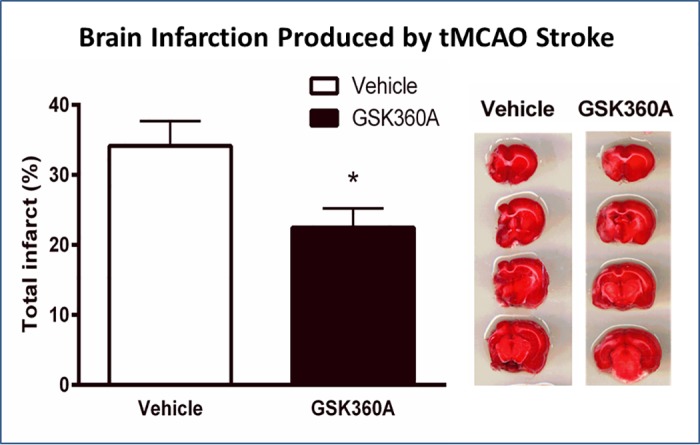
TTC staining of forebrain 2 mm thick sections conducted 4 weeks after tMCAO stroke (1 week after APA testing).GSK360A treatment resulted in a 30% decrease in hemispheric loss reflecting the decreased infarct size compared to vehicle treatment. N = 10 rats per group. t- test; *p < 0.05 when compared with vehicle group.